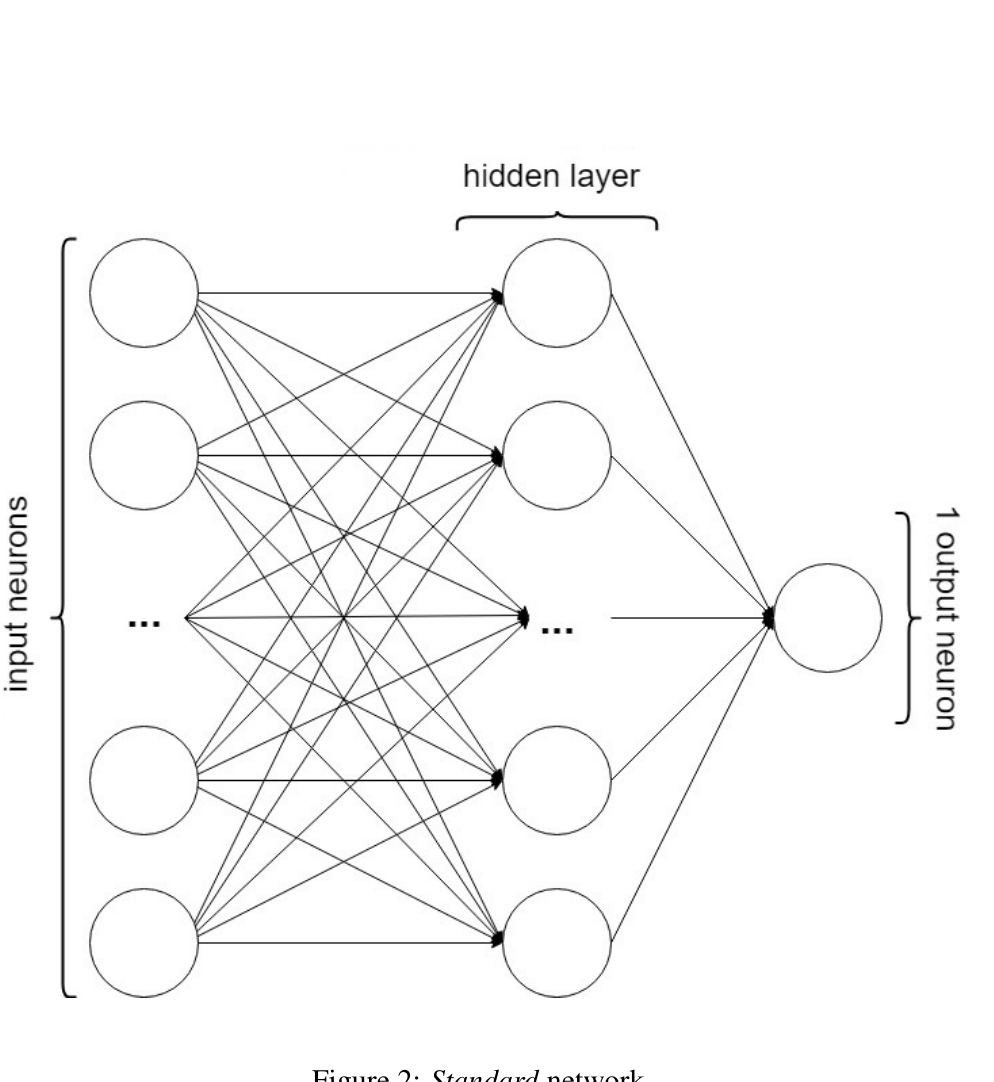
Figure 2: Standard